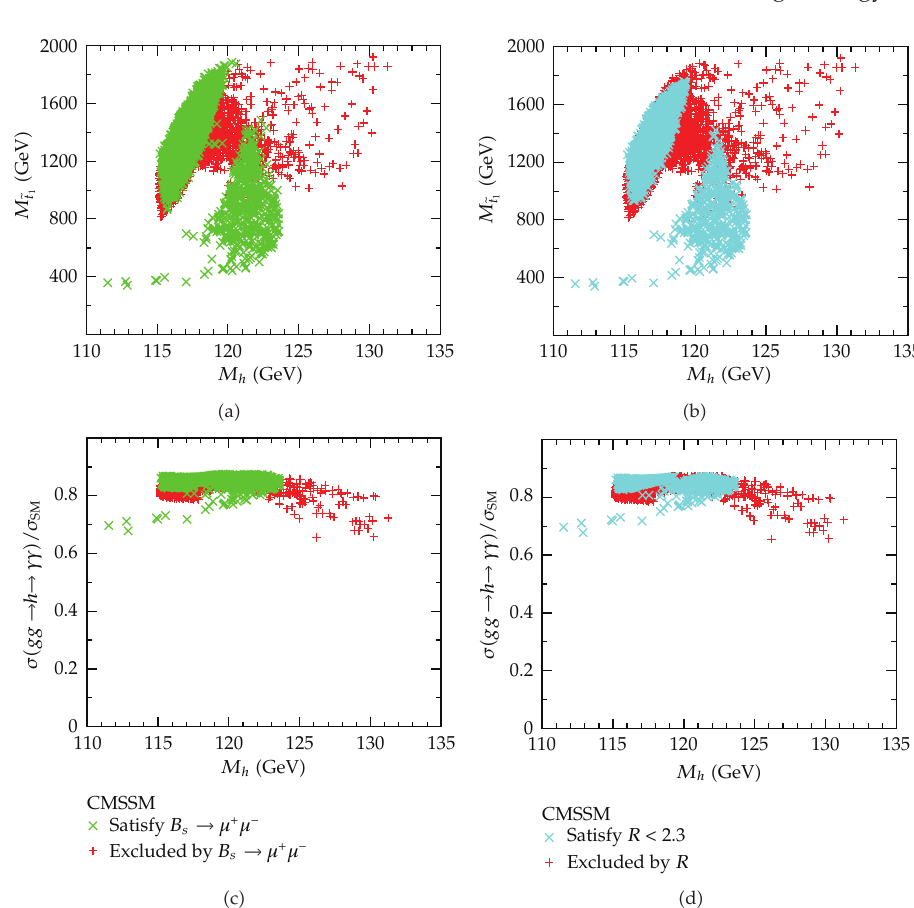
Figure 7: The scatter plots of the surviving sample in the CMSSM, displayed in the planes of the top-squark mass and the LHC di-photon rate versus the Higgs boson mass. In the left frame, the crosses (cid:3) red (cid:4) denote the samples satisfying all the constraints except B s → μ (cid:8) μ − , and the times (cid:3) green (cid:4) denote those further satisfying the Br (cid:3) B s → μ (cid:8) μ − (cid:4) constraint. In the right frame, the crosses (cid:3) red (cid:4) are the same as those in the left frame, while the times (cid:3) sky blue (cid:4) denote the samples further satisfying the R constraint (cid:3) taken for (cid:5) 43 (cid:6)(cid:4)